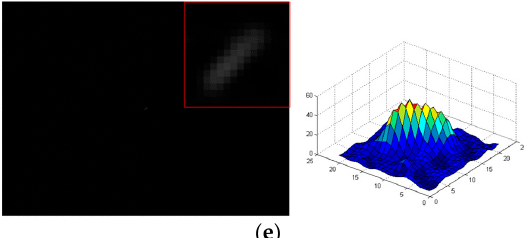
Figure 10. Denoised star images with different methods. ( a ) Star image under static condition; ( b ) blurred star image with a noise covariance of 50 and its three-dimensional distribution; ( c ) denoised star image with Bayes Shrink and its three-dimensional distribution; ( d ) denoised star image with open operation and its three-dimensional distribution; ( e ) denoised star image with the proposed algorithm and its three-dimensional distribution.